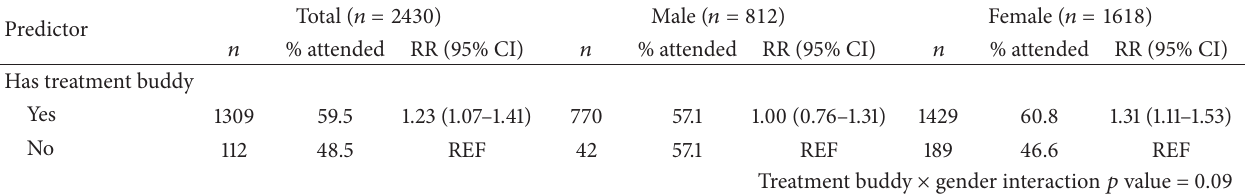
Table 2: Unadjusted relative risks for factors associated with clinic attendance during the first six months on ART, overall, and by gender.